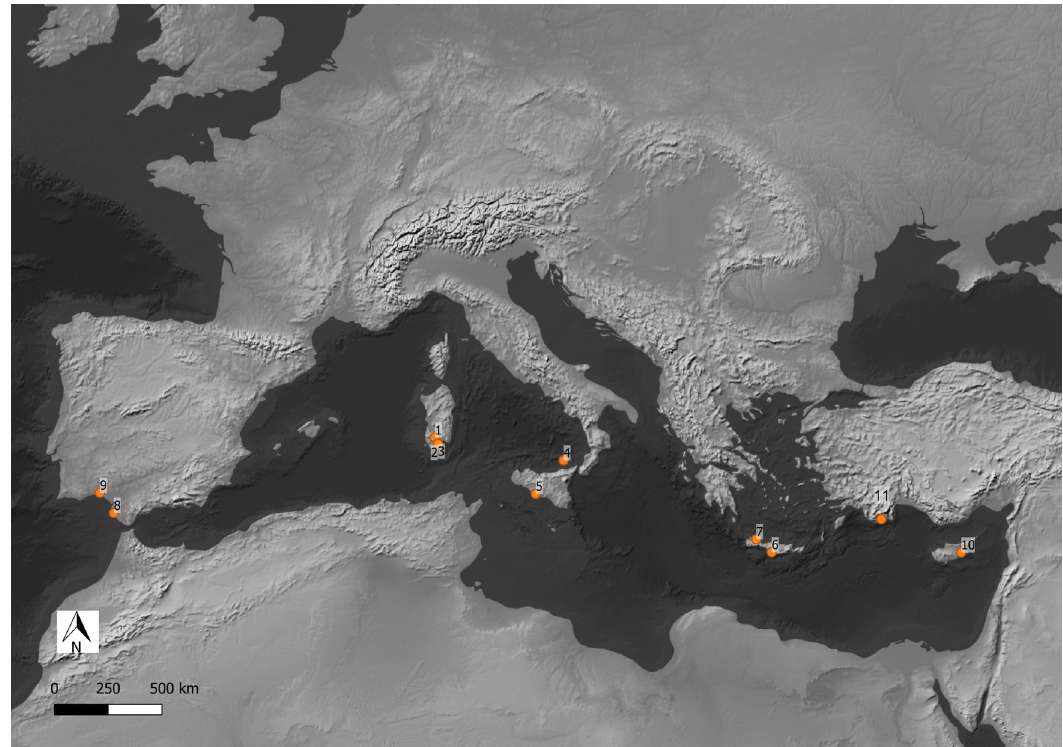
Figure 2: Nuragic trade and networks: fi rst discoveries. The image shows the location of some of the sites mentioned in the text. List: 1. Monte Sa Idda; 2. Monte Arrubiu; 3. Nuraghe Antigori; 4. Lipari; 5. Cannatello; 6. Kommos; 7. Chania; 8. Cadiz; 9. Huelva; 10. Pyla Kokkinokremos; 11. Uluburun. Map ( V. Matta )